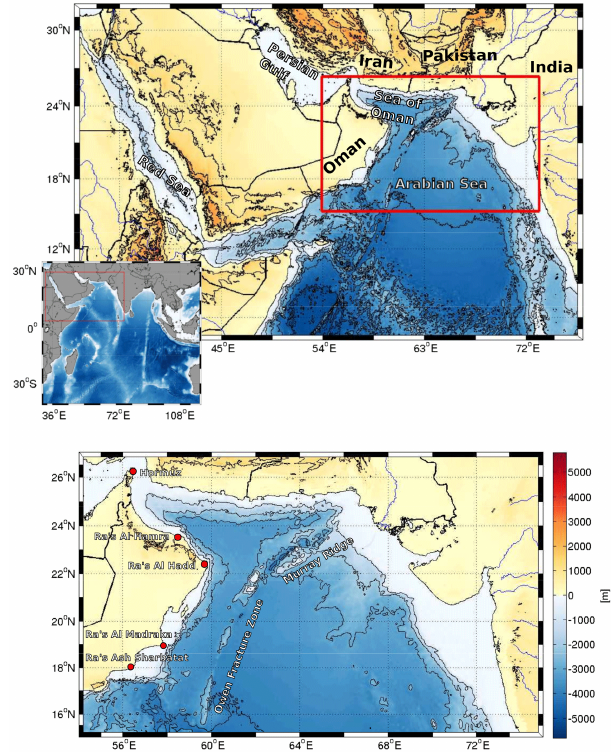
Figure 1. Maps of the northwestern Indian Ocean. Top: area cov- ered by the HYCOM model, including the Arabian Sea and the ad- jacent gulfs. Bottom: areas of interest in this paper, the Arabian Sea, the Sea of Oman and the main geographical